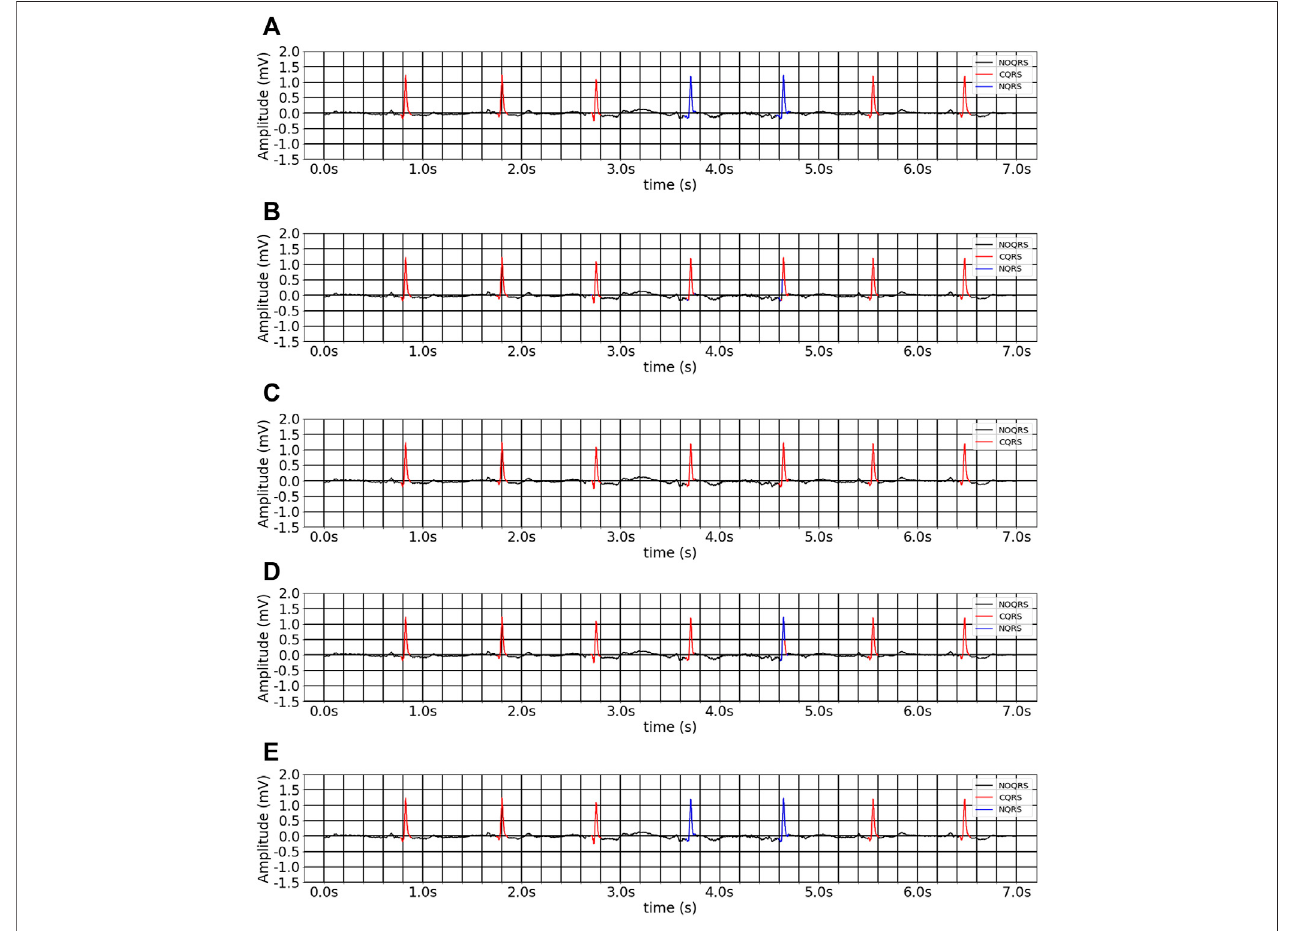
FIGURE 8 | The inter-analysis segmentation results of different methods on multitask inheritance training scheme. (A) Ground-truth ECG. (B) 1D CNN Unet. (C) FCN. (D) Unet_LUDB. (E) EBTnet.